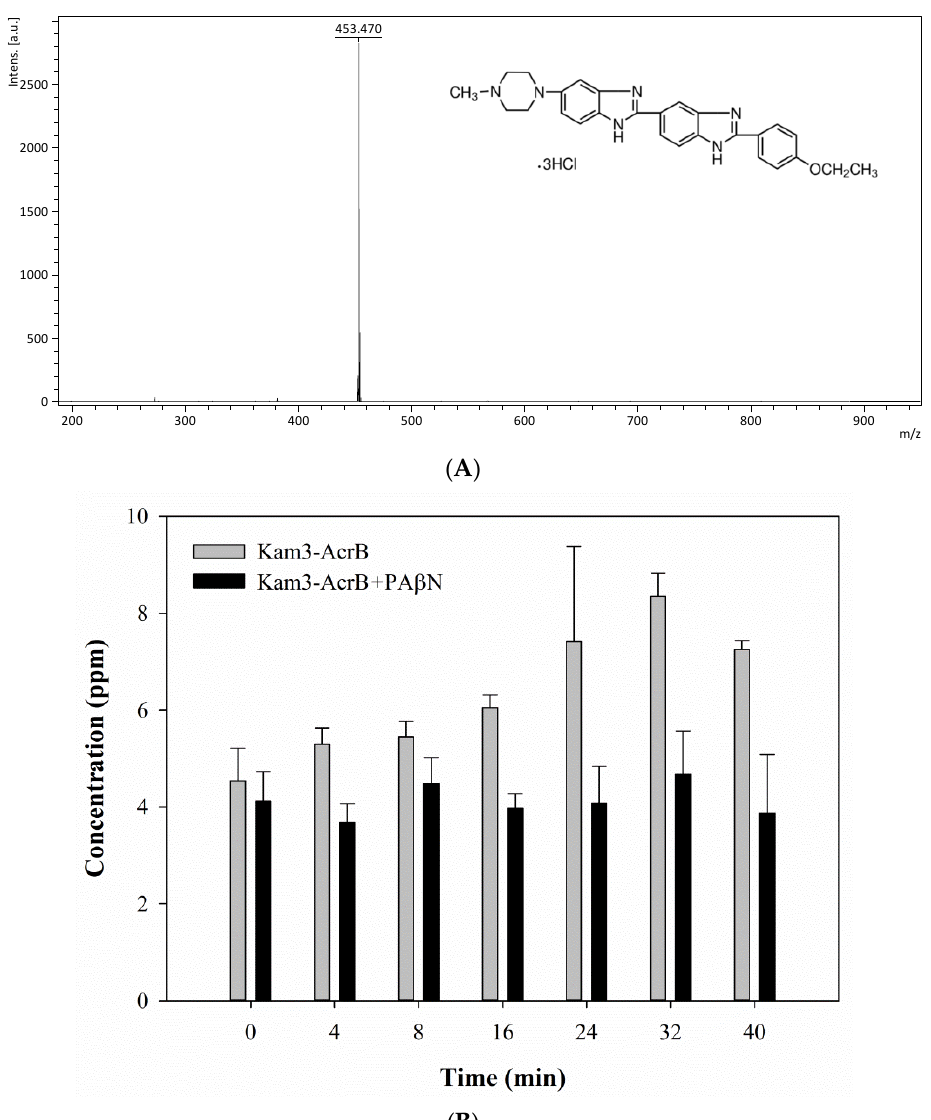
Figure 4. The Hoechst 33342 efflux activity of Kam3-AcrB was detected by using MALDI-TOF MS in the presence of modulator PAβN . ( A ) The mass spectrum of H33342 and ( B ) the intensity of extracellular H33342. The intensity was plotted at the main peak at m / z 453.47 of H33342 and the detection period was 40 min. Values are expressed as mean ± standard deviation (SD) ( n = 3).